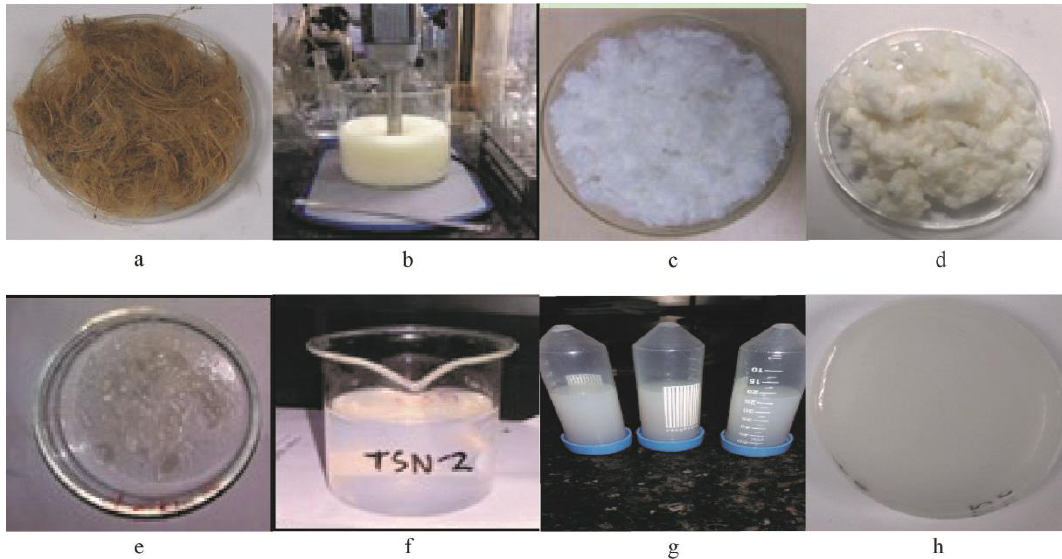
Figure 1. Production of nanocellulose from BNHF ( a . BNHF, b . Cellulose preparation, c